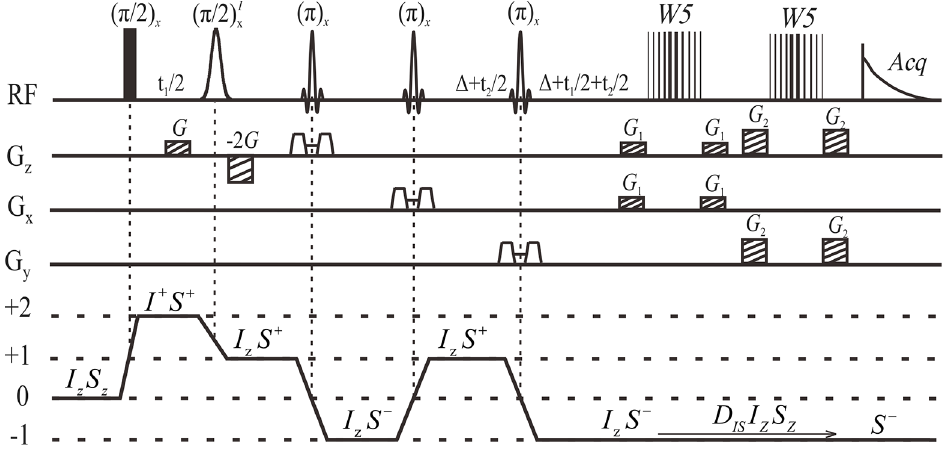
Fig 1. Pulse sequence diagram of the localized iDQC J RES. Full vertical bar is the non-selective RF pulse, Gauss-shaped pulse is solvent-selective RF pulse, Sinc-shaped pulses stand for three slice-selective refocusing π RF pulses, trapezoids along three orthogonal directions are slice-selective gradients, vertical- line represent “ W5 ” binomial π pulses. G and -2 G are coherence selection gradients, G 1 and G 2 are crasher gradients for the water suppression. The coherence transfer pathway is presented and the product operators are applied to show the coherence states of solvent I and solute S spins.